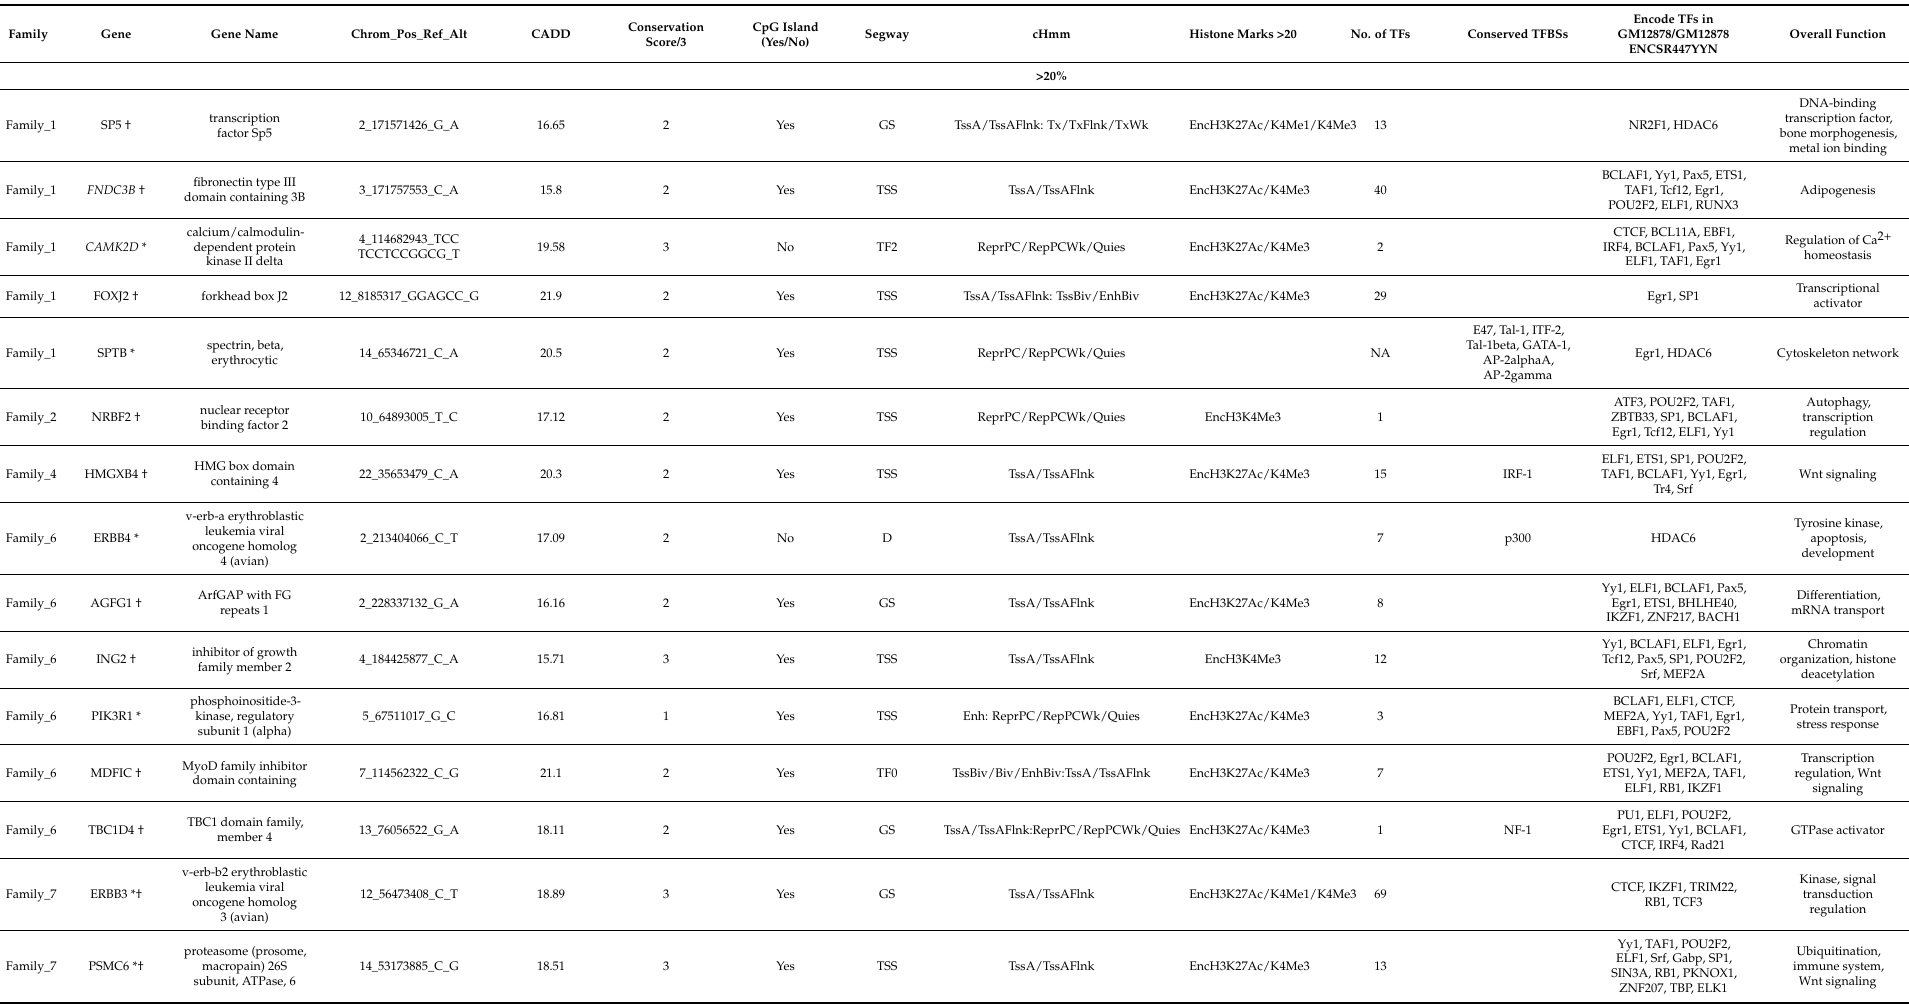
Table 1. Upstream and 5 (cid:48) UTR top and MAPK pathway variants prioritized on the basis of FCPPv2 and non-coding variant analysis tools within CADD v1.6, ENCODE TF data and Uniprot/Swiss-Prot functional